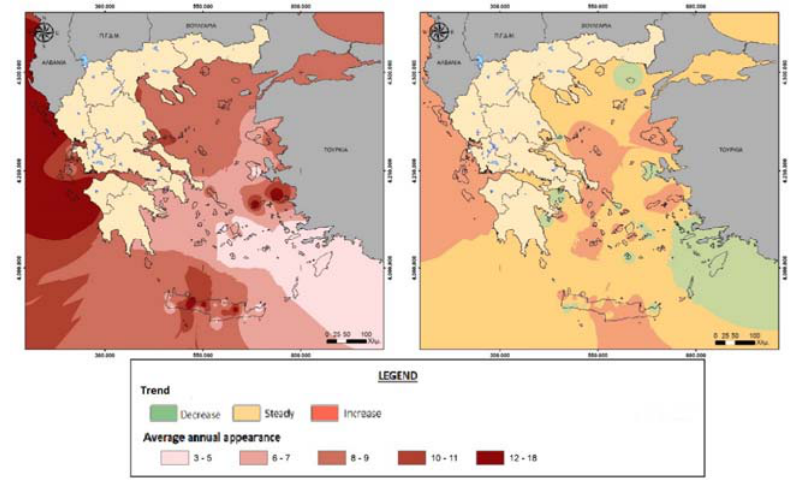
Figure 3. Rainfall frequency and